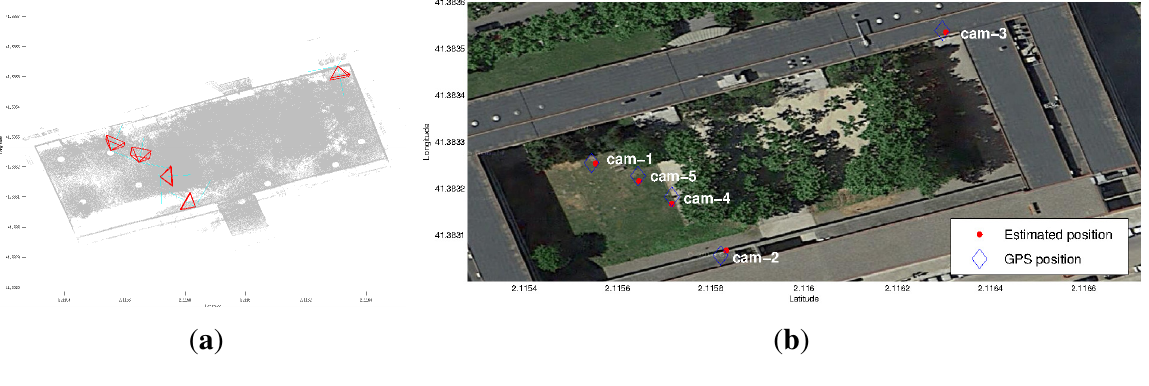
Figure 13. The results of the final calibration camera network. Optimization approximates the projected laser lines (blue) to the image lines (red) using the FME dataset. ( a )